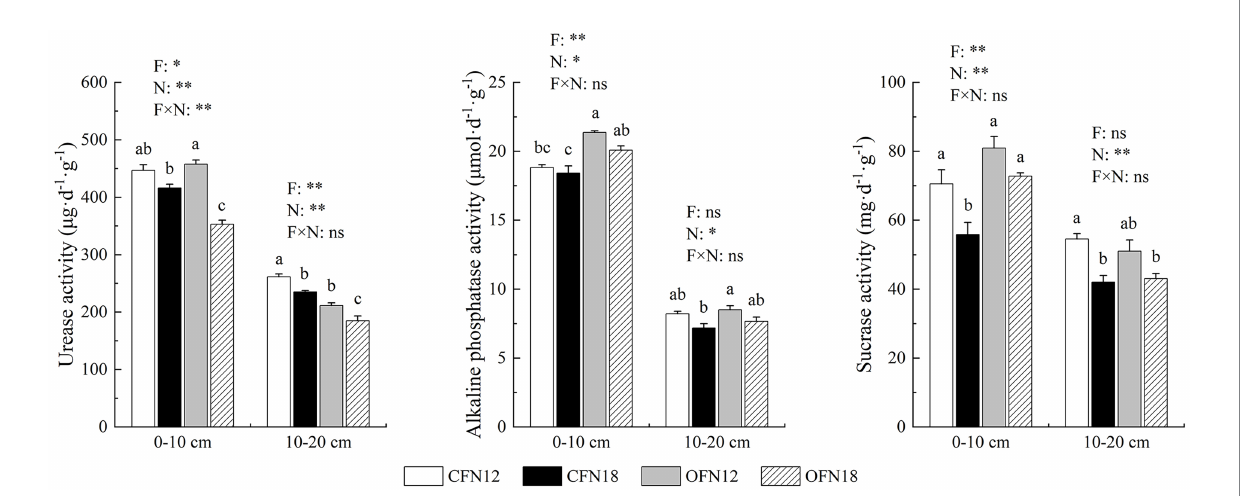
FIGURE 2 Effects of two nitrogen levels under organic and conventional cultivation on soil enzyme activities. F, Cultivation Pattern; N, Nitrogen Level; F × N, interaction between F and N. * p < 0.05, ** p < 0.01, ns p > 0.05. Different lower case letters indicate significant differences among the four treatments at p <